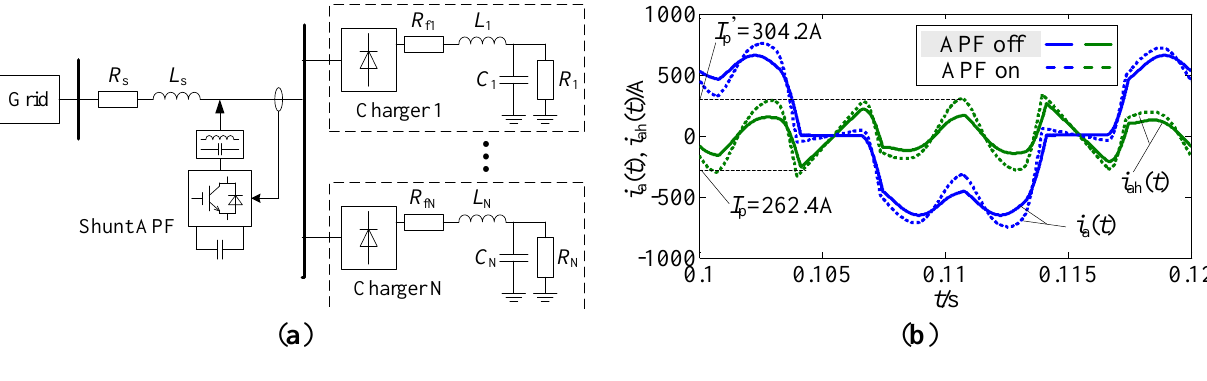
Figure 7. Single line diagram and harmonic current amplification of charging station. ( a ) Single line diagram of charging station; ( b ) Charging current and its harmonic component for the charging